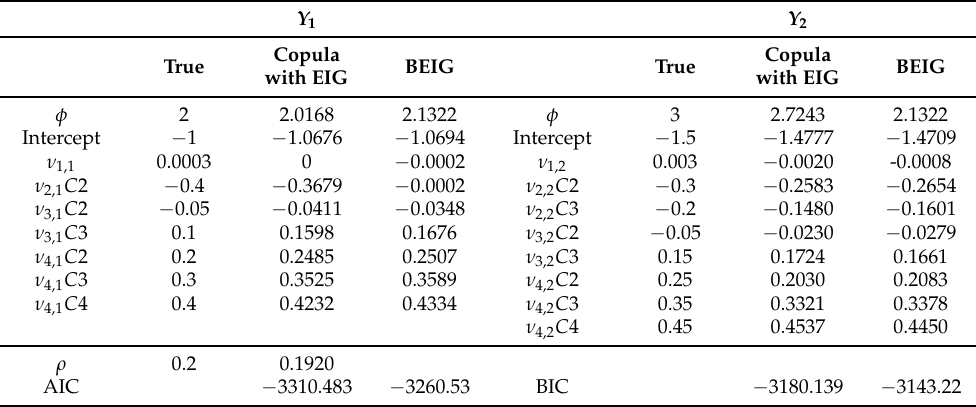
Table 5. Model comparison between Gaussian copula model with two EIG marginals and BEIG regression model. Data are generated from Gaussian copula with two EIG marginals. The AIC and BIC values are for the bivariate model. Y